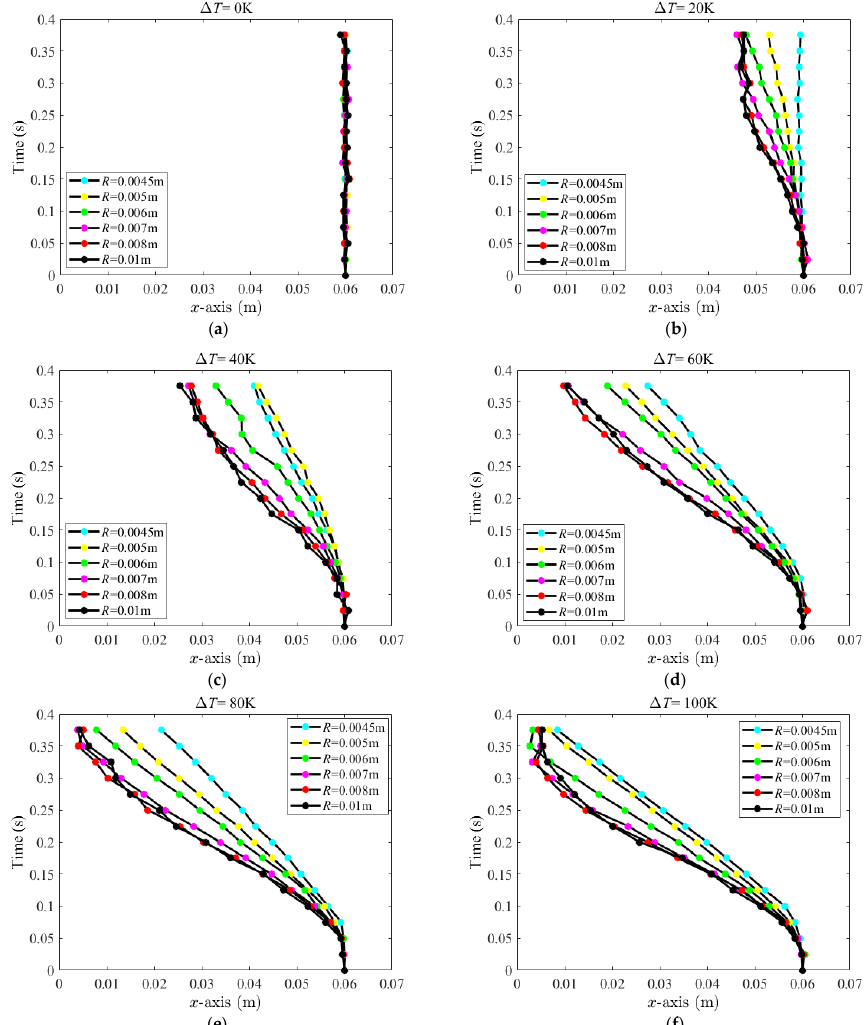
Figure 7. Schematic representation of the movement of the bubbles with different bubble radii in the x -direction under different lateral temperature gradients ( a ) ∆𝑇 = 0 K , ( b ) ∆𝑇 = 20 K , ( c ) ∆𝑇 = 40 K , ( d ) ∆𝑇 = 60 K , ( e ) ∆𝑇 = 80 K and ( f ) ∆𝑇 = 100 K . x -direction under different lateral temperature gradients ( a ) ∆ T = 0 K, ( b ) ∆ T = 20 K, ( c ) ∆ T = 40 K, ( d ) ∆ T = 60 K, ( e ) ∆ T = 80 K and ( f ) ∆ T = 100